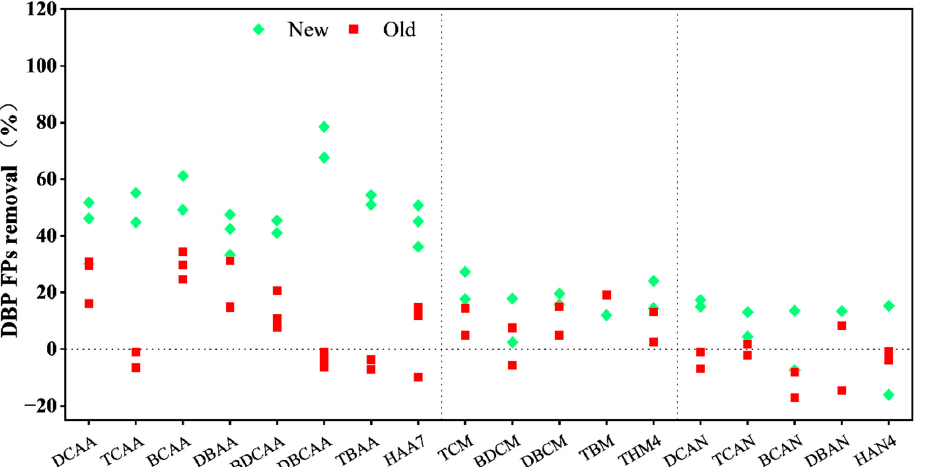
Figure 1. The removal of formation potential of THMs, HAAs, and HANs during the chlorination of old and new BAC filters. Scattered point of HAA FPs represents a single sample and other scattered point represents the average of three replicate samples.